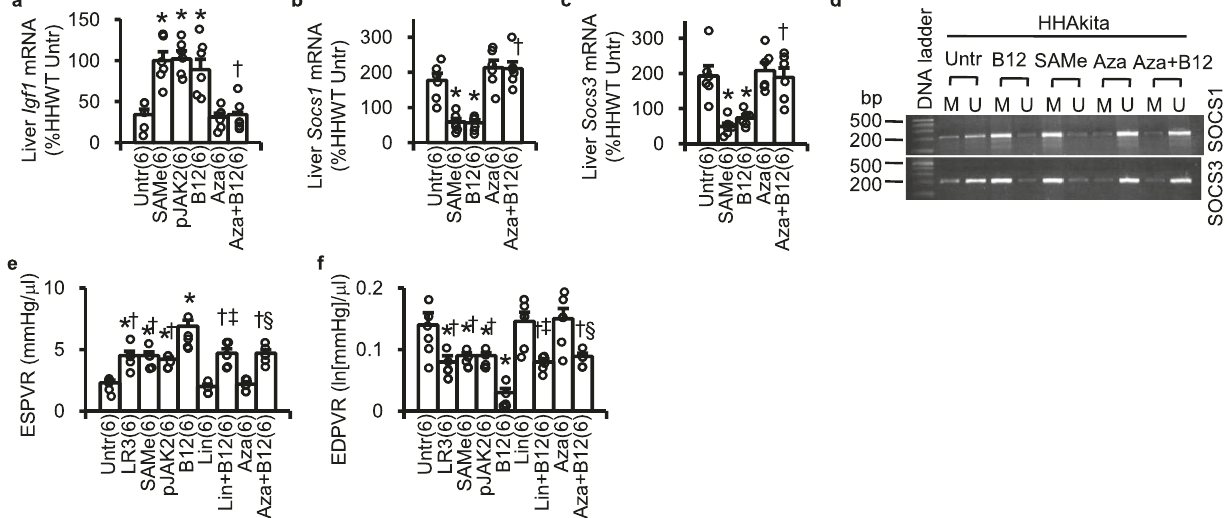
Fig. 7 DNMTs-SOCS1/3-IGF-1 pathway on the cardioprotective effects of B12. a Liver Igf1 mRNA, b Liver Socs1 mRNA, and c Liver Socs3 mRNA of Elmo1 H/H Ins2 Akita/ + mice treated for 16 weeks with S-adenosylmethionine (SAMe; 200mg/kg/day PO), a SOCS1/3 inhibitor pJAK2(1001 – 1013) (pJAK2; 50mg/kg/day IP), B12 alone, and a DNMT inhibitor 5-aza-2 ’ -deoxycytidine (Aza; 10mg/kg/day IP) with or without B12 compared with those for untreated (Untr) or and treated mice with B12 only (the same as those in Figs. 5 and 6). mRNA levels normalized by β -actin mRNA are expressed relative to the mean levels in HHWT mice as 100%. * P <0.05 vs. Untr; † P <0.05 vs. B12 only. d PCR products ampli fi ed with methylation (M) and unmethylation (U)-speci fi c primers for the promoters of SOCS1 and SOCS3 using 50ng of bisul fi te-treated liver DNA. The fi rst lane of the panels shows DNA size markers. e End-systolic pressure – volume relationship (ESPVR) determined by pressure – volume loop analysis and f End-diastolic pressure – volume relationship (EDPVR) of the Elmo1 H/H Ins2 Akita/ + mice assessed after 8 weeks of treatments with a long-acting IGF-1 analog IGF-1 Long R3 (LR3; 1mg/kg/day IP), SAMe, pJAK2, and an IGF-1 receptor inhibitor linsitinib (Lin; 50mg/kg/day PO) and Aza with and without B12. Data are expressed as means±standard errors. * P <0.05 vs. Untr; † P <0.05 vs. B12; ‡ P <0.05 vs. Lin; § P <0.05 vs. Aza; by Tukey – Kramer Honestly Signi fi cant Differences